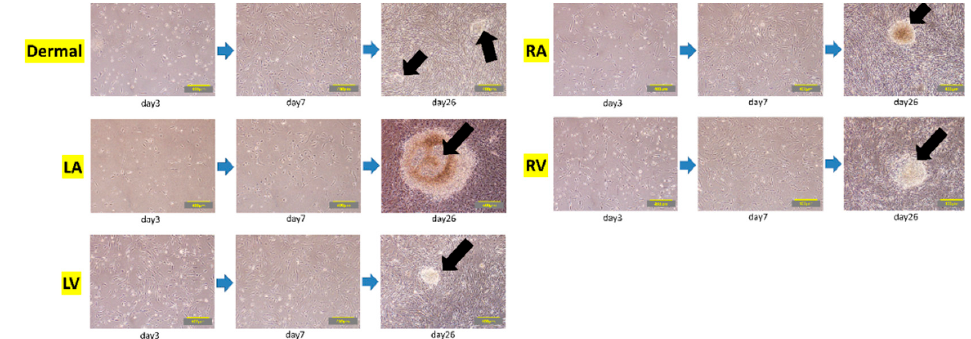
Figure 6. Induction of iPS cell colonies in myocardial fibroblasts from a heart transplant recipient. The process of iPS cell induction in dermal fibroblasts (dermal) and in myocardial fibroblasts from the left atrium (LA), left ventricle (LV), right atrium (RA), and right ventricle (RV) from a heart transplant recipient. Gene transfection was performed on day 1. Images show the cells on day 3, day 7, and day 26 post-transfection. Arrows indicate the iPS cell colonies that were eventually induced. Scale bars: 400 µm.